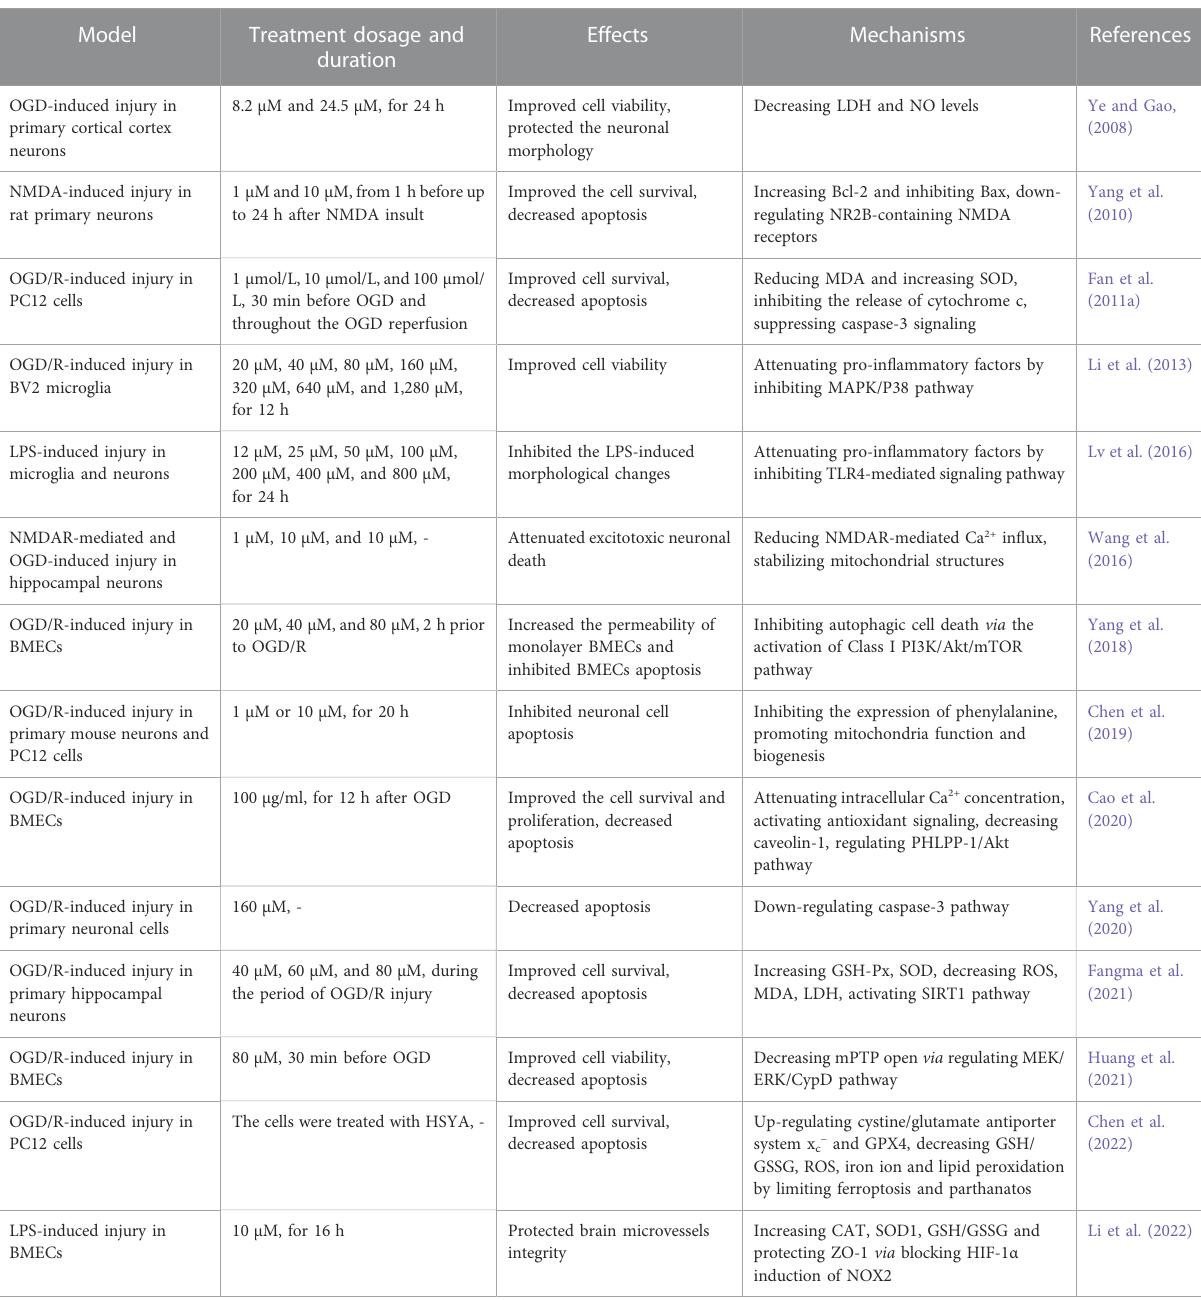
TABLE 2 Protective effects of HSYA against cerebral I/R injury under in vitro